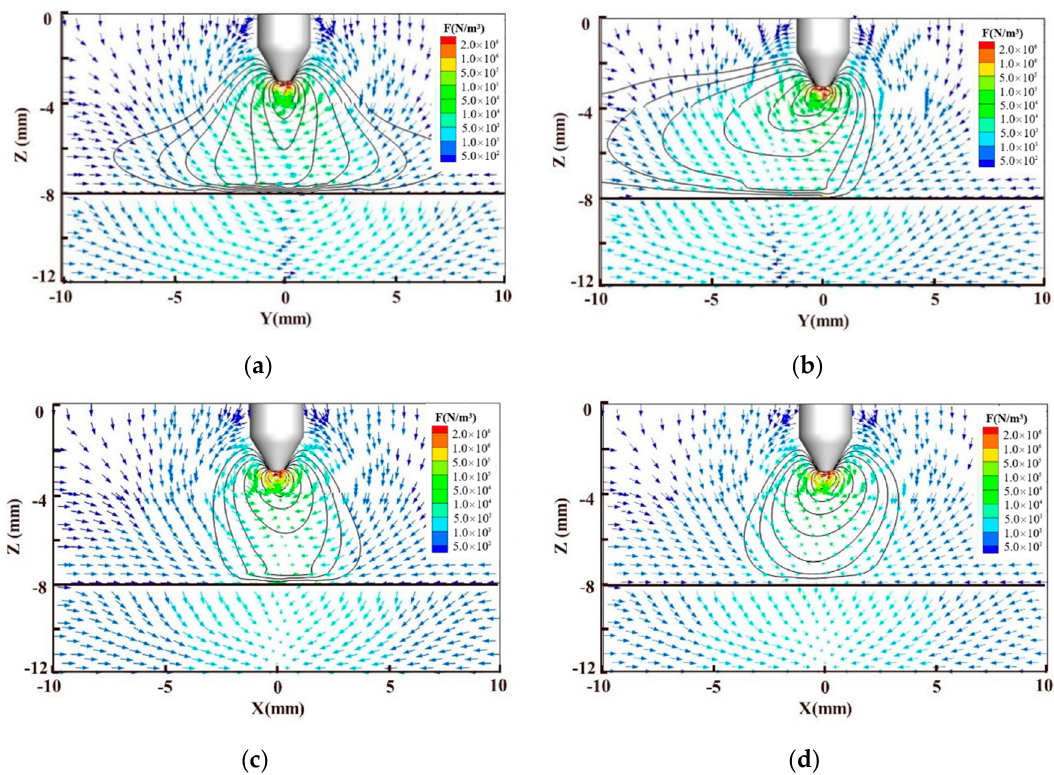
Figure 13. Self-induced electromagnetic force: ( a ) I e = 0 ( yoz plane), ( b ) I e = 3 A, t = t 1 ( yoz plane), ( c ) I e = 3 A, t = t 1 ( xoz plane), and ( d ) I e = 3 A, t = t 2 ( xoz plane).